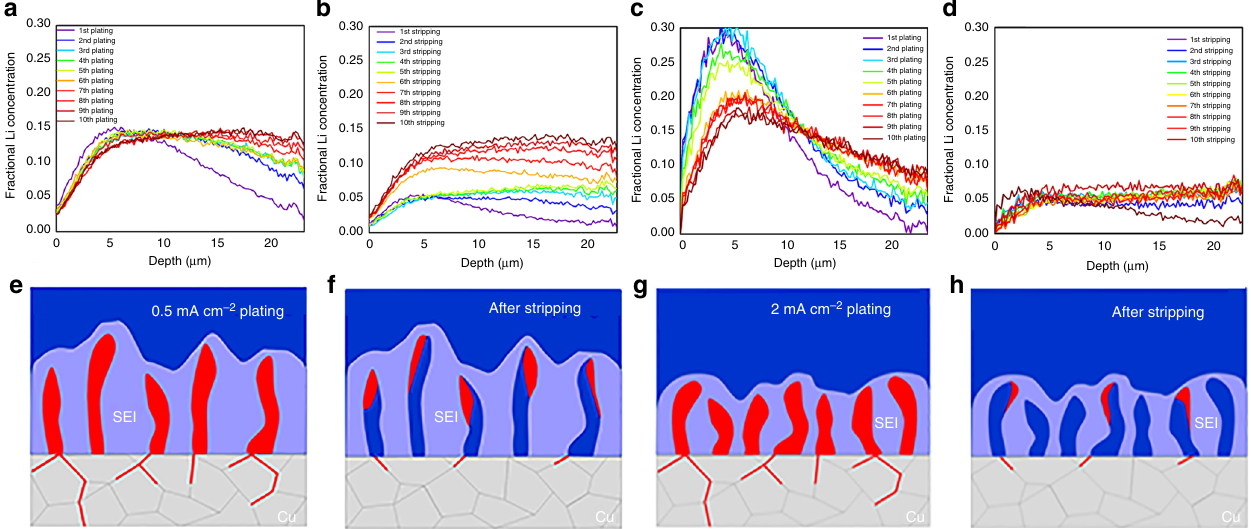
Fig. 6 Impact of plating history on the density during plating and stripping. a Fractional Li density from operando NDP in Fig. 5a after plating and b after stripping for fi ve cycles at 0.5 mA cm – 2 followed by fi ve cycles at 2.0 mA cm – 2 and c after plating and d after stripping for fi ve cycles at 2.0 mA cm – 2 followed by fi ve cycles at 0.5 mA cm – 2 . The depth is measured starting from the interface of the Cu current collector with the electrolyte/SEI/Li-metal. e – h Schematic representation of the plating and stripping process at 0.5 and 2.0 mA cm – 2 based on the evolution of the Li density observed with operando